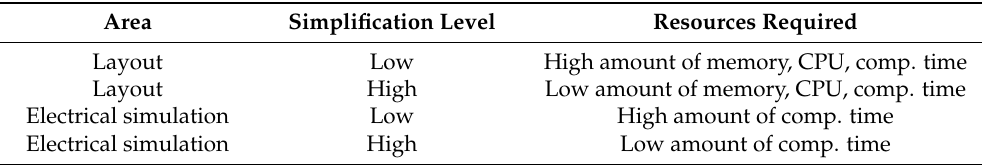
Table 3. Areas of the model simplification and its effects. Area Simplification Level Resources Required